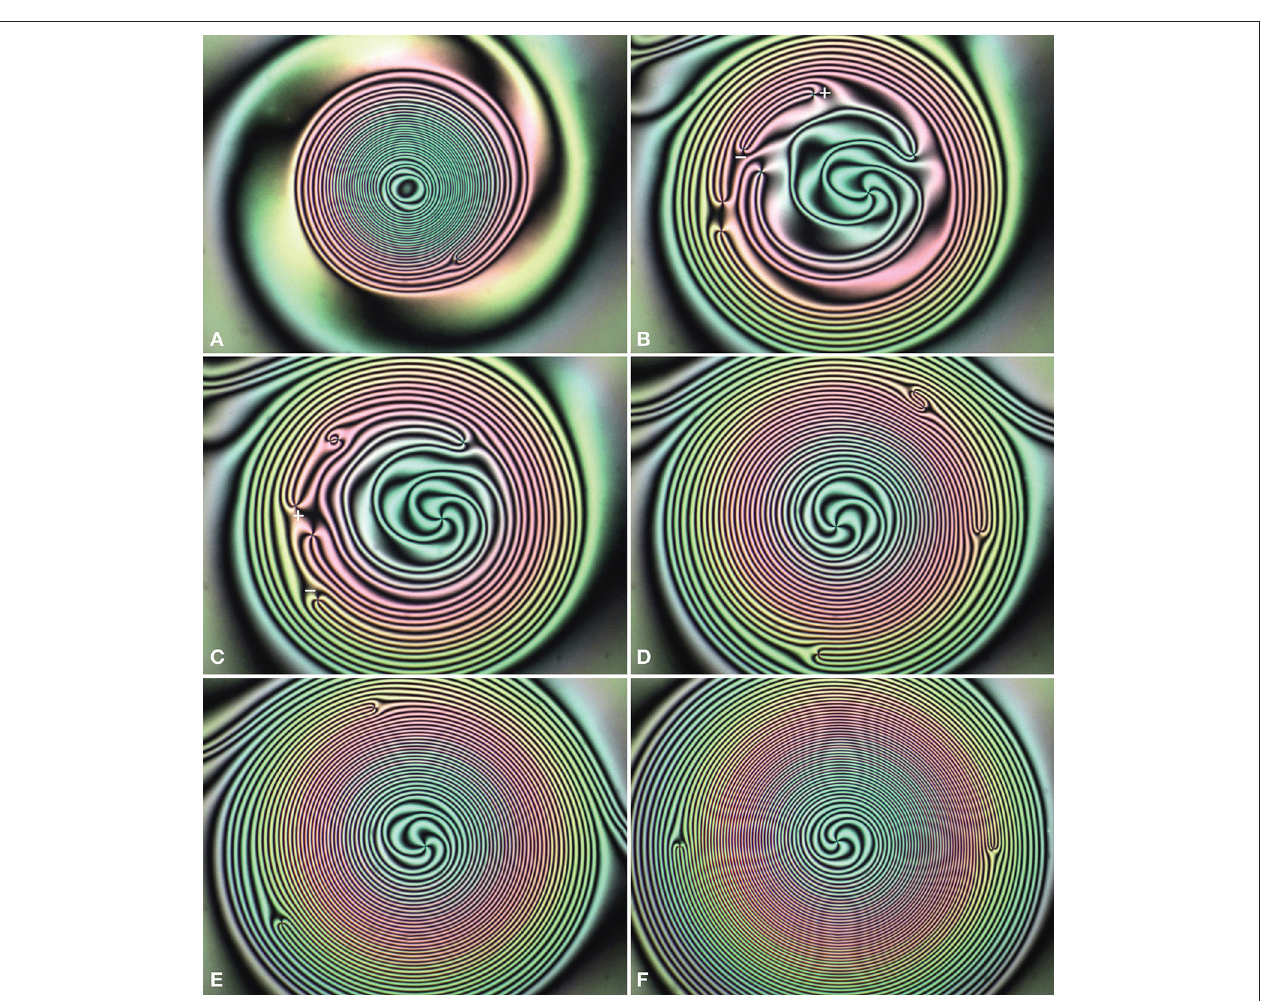
FIGURE 11 | Generation of the dynamically stable “triplet” configuration of dowsons during the phase winding in the Circular Dowsons’ Collider. (A) First, the Cladis-Brand configuration of one orbiting d + dowson is generated as shown in Figure 8 . (B) Application of a transitory shear flow to the Cladis-Brand state results in generation of three additional dowsons pairs (d + ,d − ). One these pairs is labeled as “+” and “ − .” (C) Annihilation of the (d + ,d − ) pair labeled in (B) . The second (d + ,d − ) pair is labeled as “+” and “ − .” (D) Annihilation of the (d + ,d − ) pair labeled in (C) . Only three dowsons are left. (E) Continuation of the winding process. (F) Dynamically stable trio of three dowson: two dowsons d + are orbiting around the dowson d − which stays in the center.